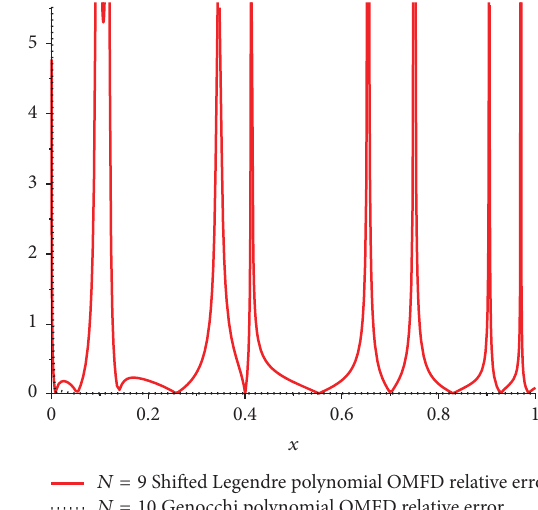
Figure 1: Comparison of relative error of operational matrix of fractional derivative (OMFD) with 𝛼 = 0.5 between 𝑁 = 9 Shifted Legendre polynomials and 𝑁 = 10 Genocchi polynomials.